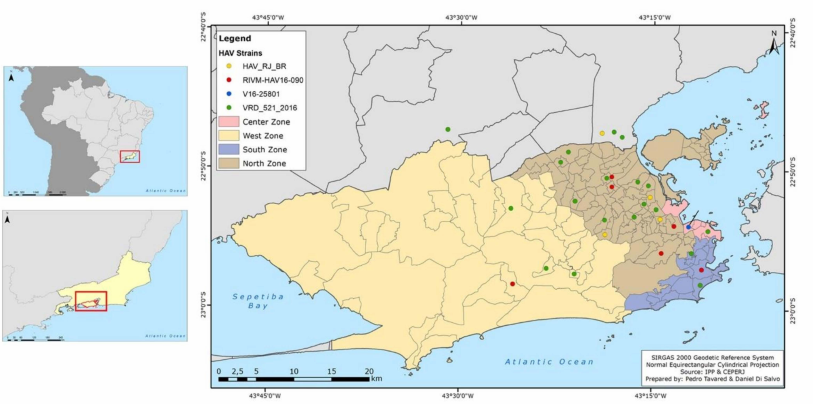
Figure 5. Distribution map of viral strains found in the study according to neighbor- hood/geographical area of Rio de Janeiro city. Geographical zones are colored: The viral strains found identified by colored dots: green ( • ) (VRD_521_2016 strain); red ( • ) (RIVM-HAV16-090 strains); blue ( • ) (V16-25801 strain); and yellow ( • ) Brazilian endemic strain (named as ‘HAV_RJ_BR’). All information can be seen in the legend on the top left.